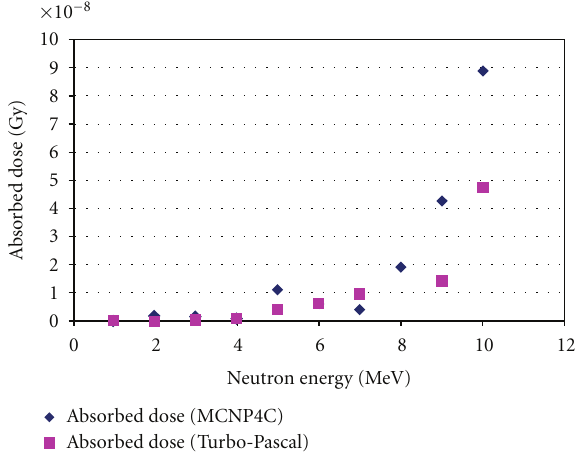
Figure 6: The absorbed dose in the liver tissue.